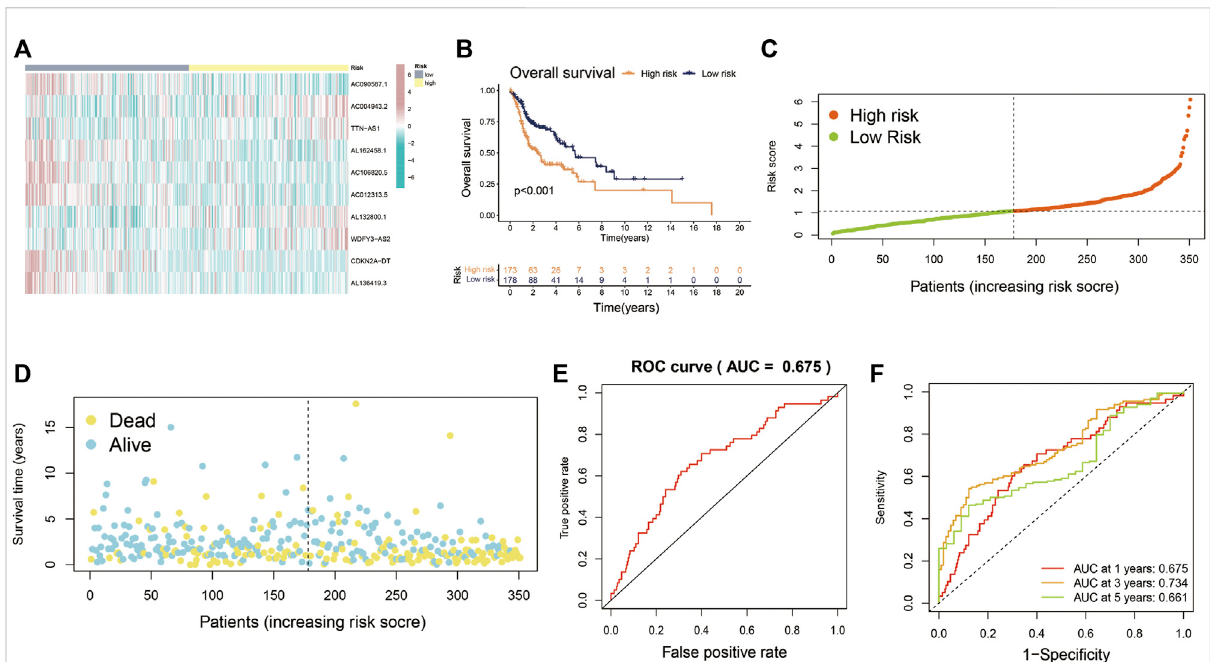
FIGURE 3 Evaluation of Cupr-RLPS in the training cohort. (A) Heatmap showed the expression of the 10 Cupr-RLs in high-risk and low-risk groups in training cohort. (B) K-M curves showed the signi fi cant differences between the survival outcome in the high-risk group and low-risk group. (C) Risk score distributionplot showed thepatients ’ distribution of HNSC in high-risk and low-riskgroups in thetraining cohort. (D) Scatter plotdepicted the relationship between the survival status and the risk score in the training cohort of HSNC patients. (E) Receiver operating characteristic (ROC) curves represented for the prognostic signature in training cohort. (F) AUC value showed 1, 3, and 5 years ’ predictions in training cohort.